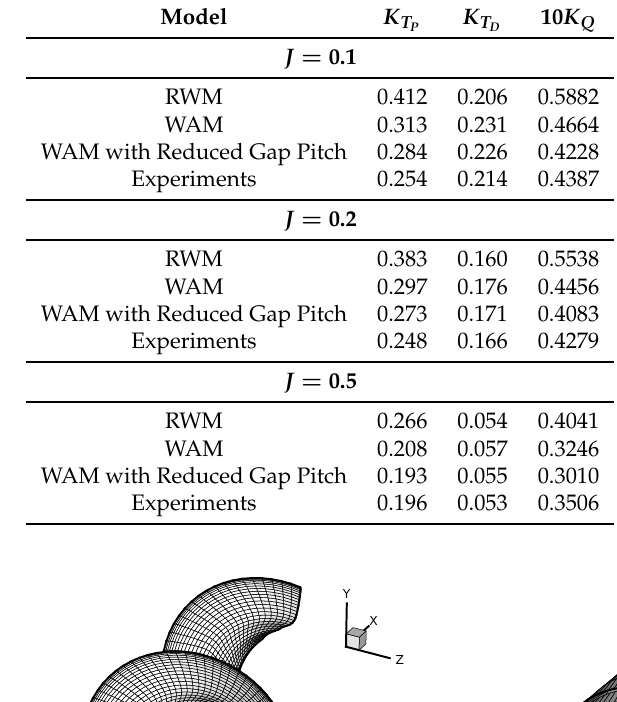
Table 3. Inviscid thrust and torque coefficients for J = 0.1, 0.2 and 0.5 and comparison with experimental data [23]. Influence of the wake model.